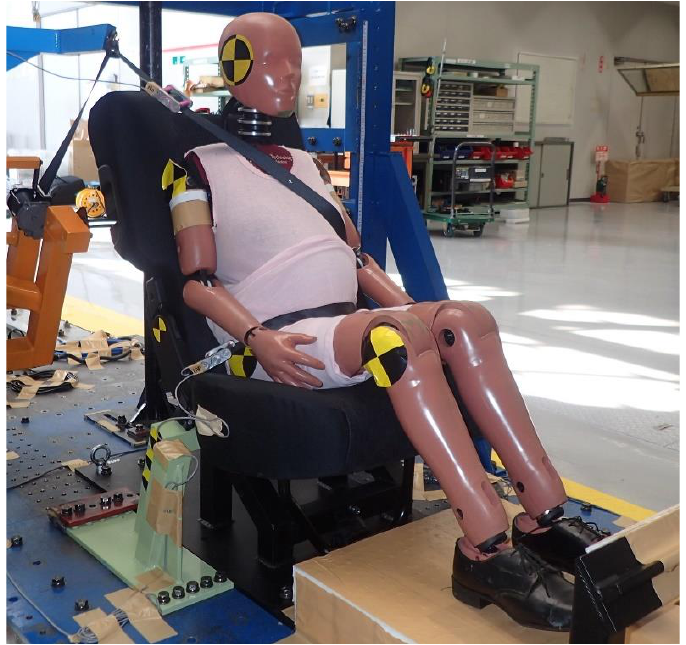
Figure 1. Version 2B of the Maternal Anthropometric Measurement Apparatus (MAMA-2B), re- strained in the test setup using a correctly positioned conventional seatbelt.